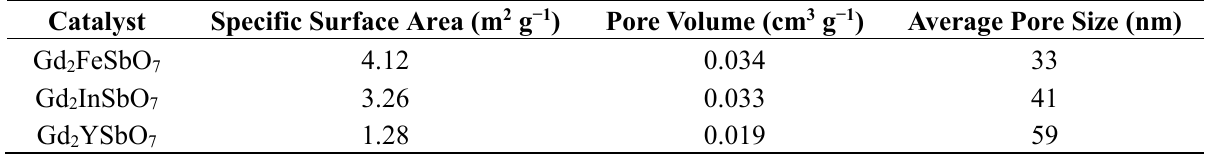
Table 4. The detailed information about the specific surface area, pore volume, average pore size of Gd 2 FeSbO 7 , Gd 2 InSbO 7 and Gd 2 YSbO 7